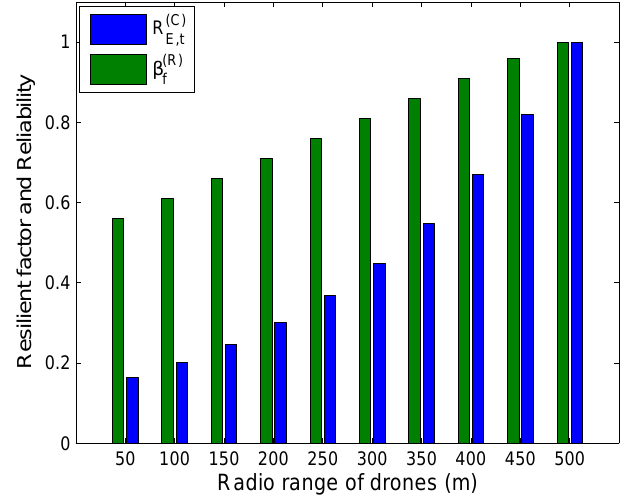
Figure 7. Resilient factor and reliability vs. radio range of